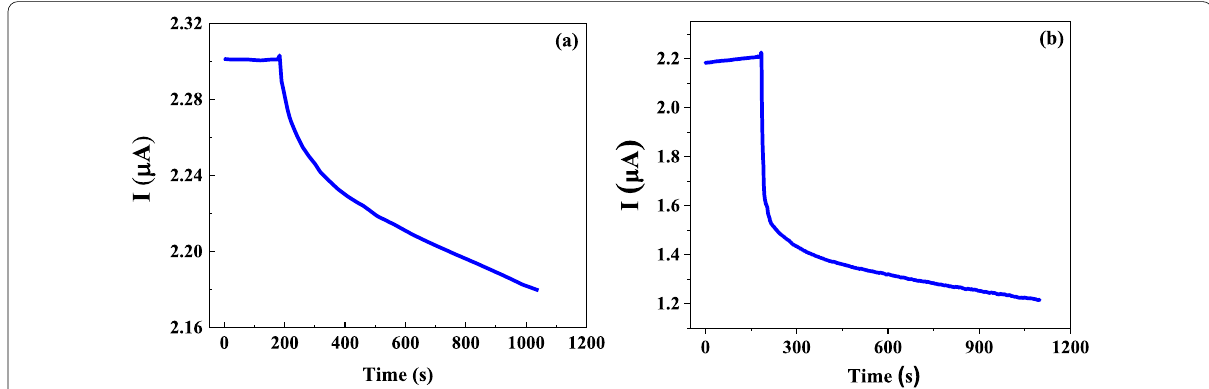
Fig. 3 a Electrical response for bare cell culture medium, and b cancer solution with 30